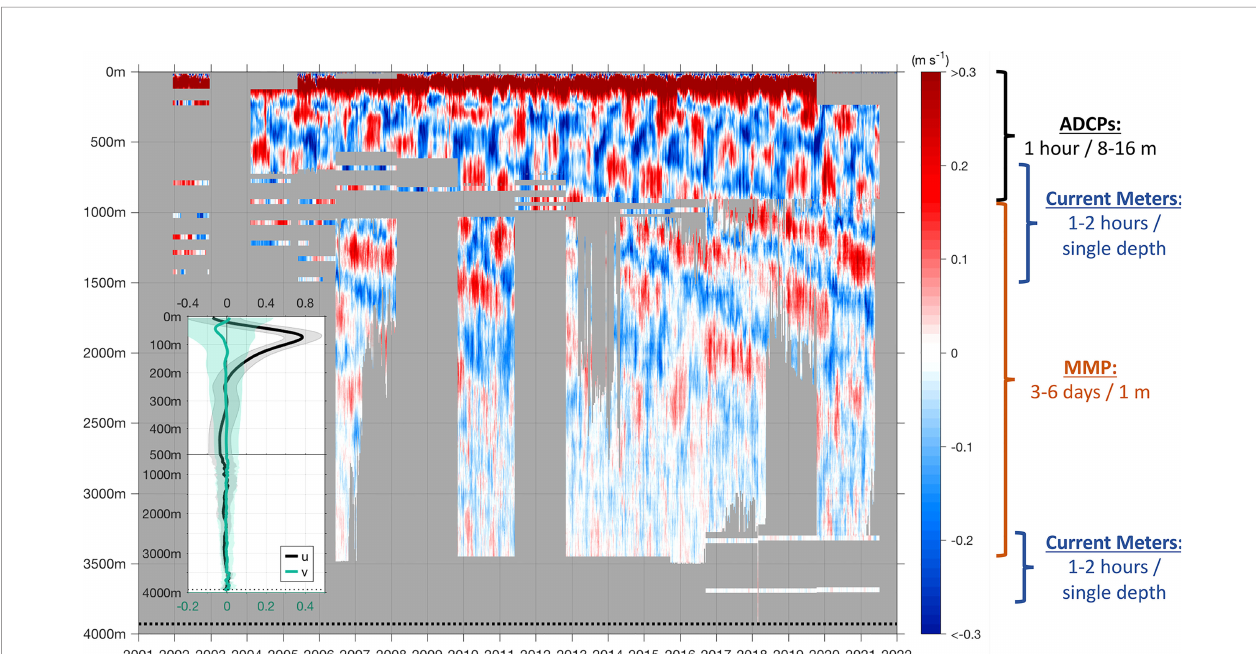
FIGURE 1 | Zonal current velocity time series from the moored observatory at 0°N, 23°W. For reference, the original temporal and vertical resolutions of the different instrument types are indicated on the right side. Current meter data below the ADCP range are stretched ±15 m about the nominal depth of the instrument. Note that the color bar is limited to velocities of up to ±0.3 m s -1 in order to visualize the deep equatorial circulation. The Equatorial Undercurrent (EUC) in the upper 200 m generally exceeds eastward velocities of 0.8 m s -1 . Also shown are the vertical mean pro fi les of zonal (u) and meridional (v) velocity (in m s -1 ) in the inset (thick lines) and their standard deviation (shaded envelopes). Please note the different axes for zonal velocity (black; top axis) and meridional velocity (green; bottom axis). The dashed lines indicate the water depth at the mooring location at approximately 3930